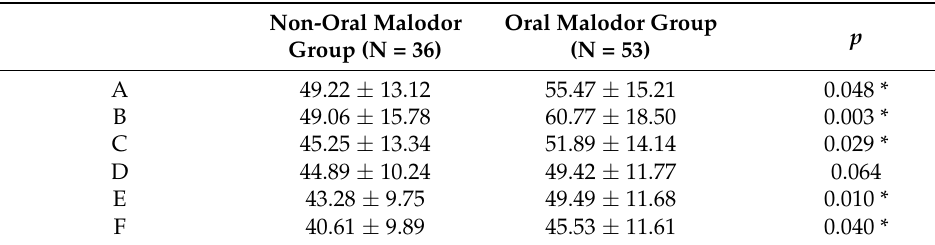
Table 2. Comparison of distribution by tongue-coating area in non-oral malodor group and oral malodor group (Unit: %).